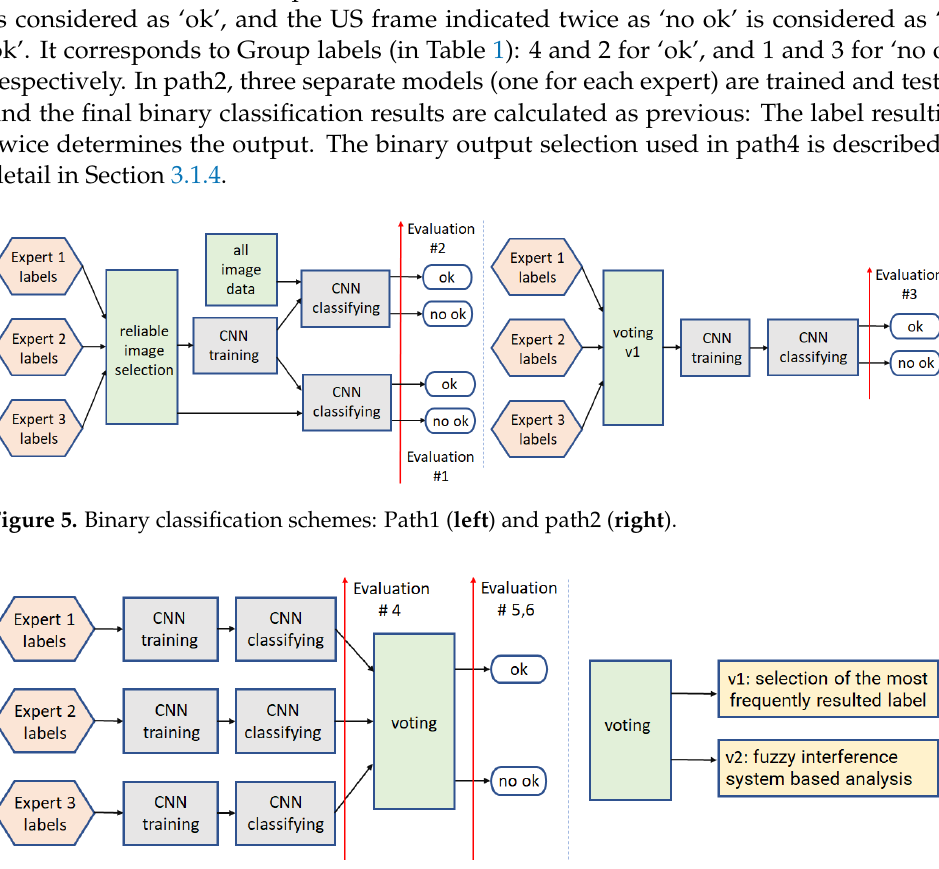
Figure 6. Binary classification schemes: Path3 and path4, utilizing two different voting algorithms, v1 and v2,